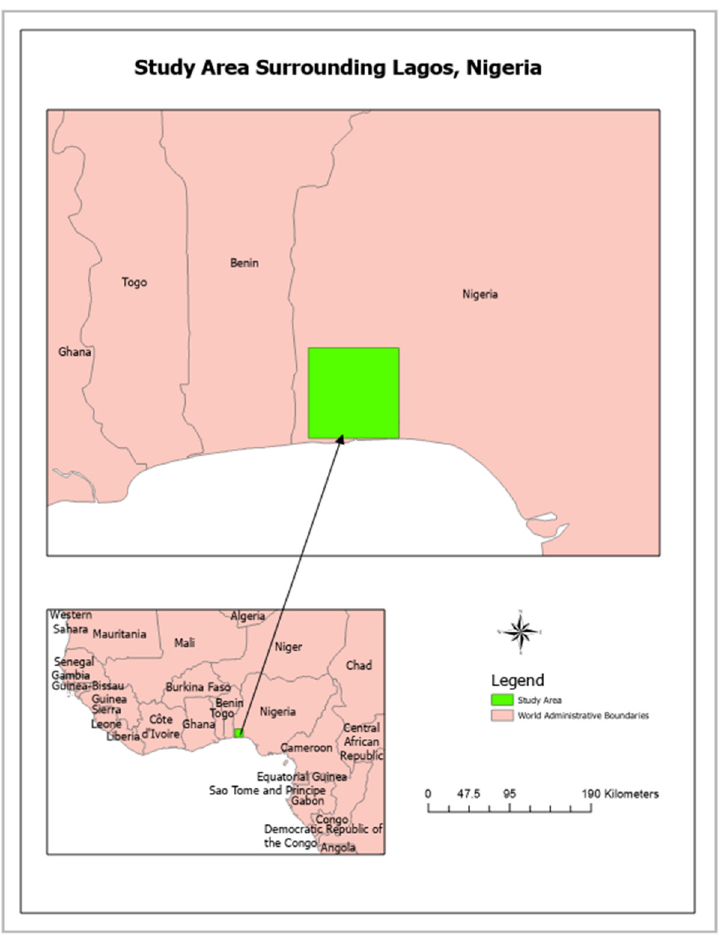
Figure 1. Study area surrounding Lagos, Nigeria (green rectangular region).